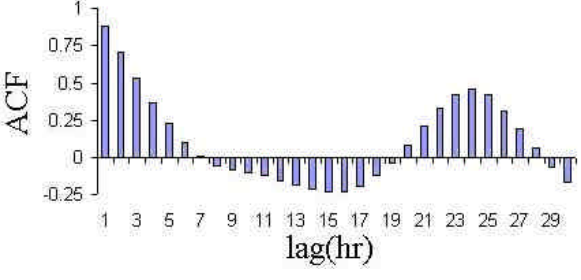
Figure6. Wind speed auto correlation function against time.